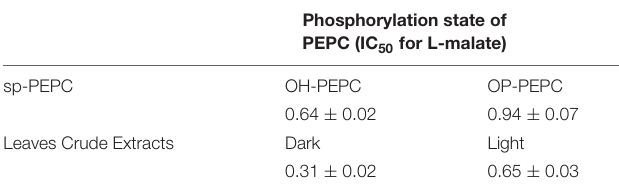
TABLE 1 | The efficacy of in vitro phosphorylation of PEPC with PKA (sp-PEPC), and the in vivo phosphorylation state of PEPC in leaves exposed to light (phosphorylated PEPC) or dark (dephosphorylated PEPC) were determined via the L-malate sensitivity test as is described in M & M and Echevarria et al., 1994). Phosphorylation state of PEPC (IC 50 for L-malate)